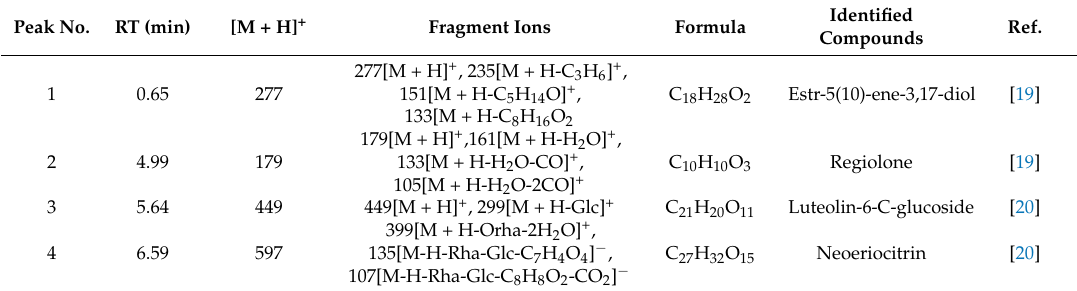
Table 1. Identification of EPE3k by